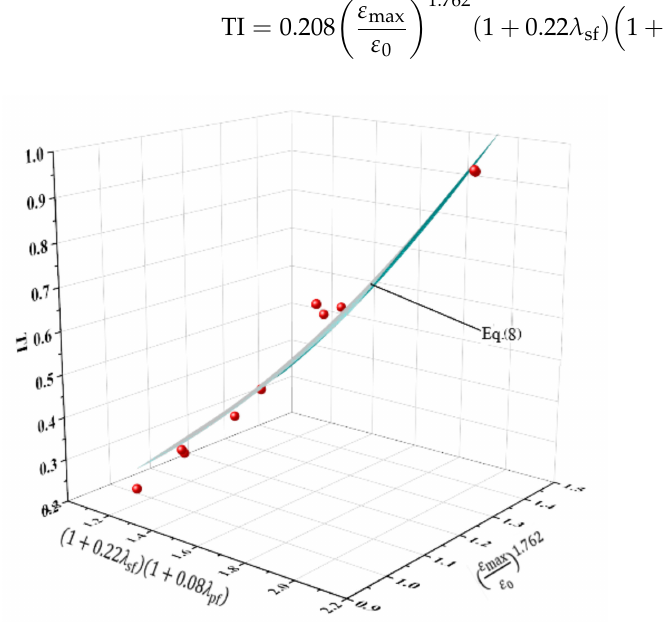
Figure 17. The relationship of fibre characteristic value, peak strain, ultimate strain, and uniaxial compression toughness index.